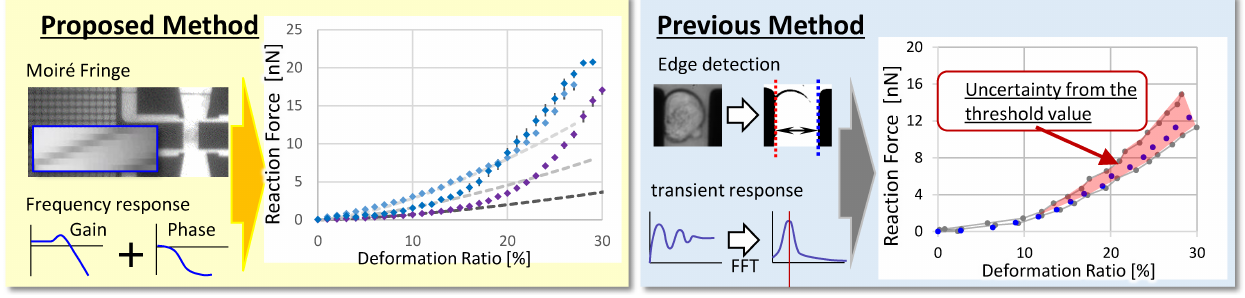
Figure 9. Performance of the proposed measurement method and previous method